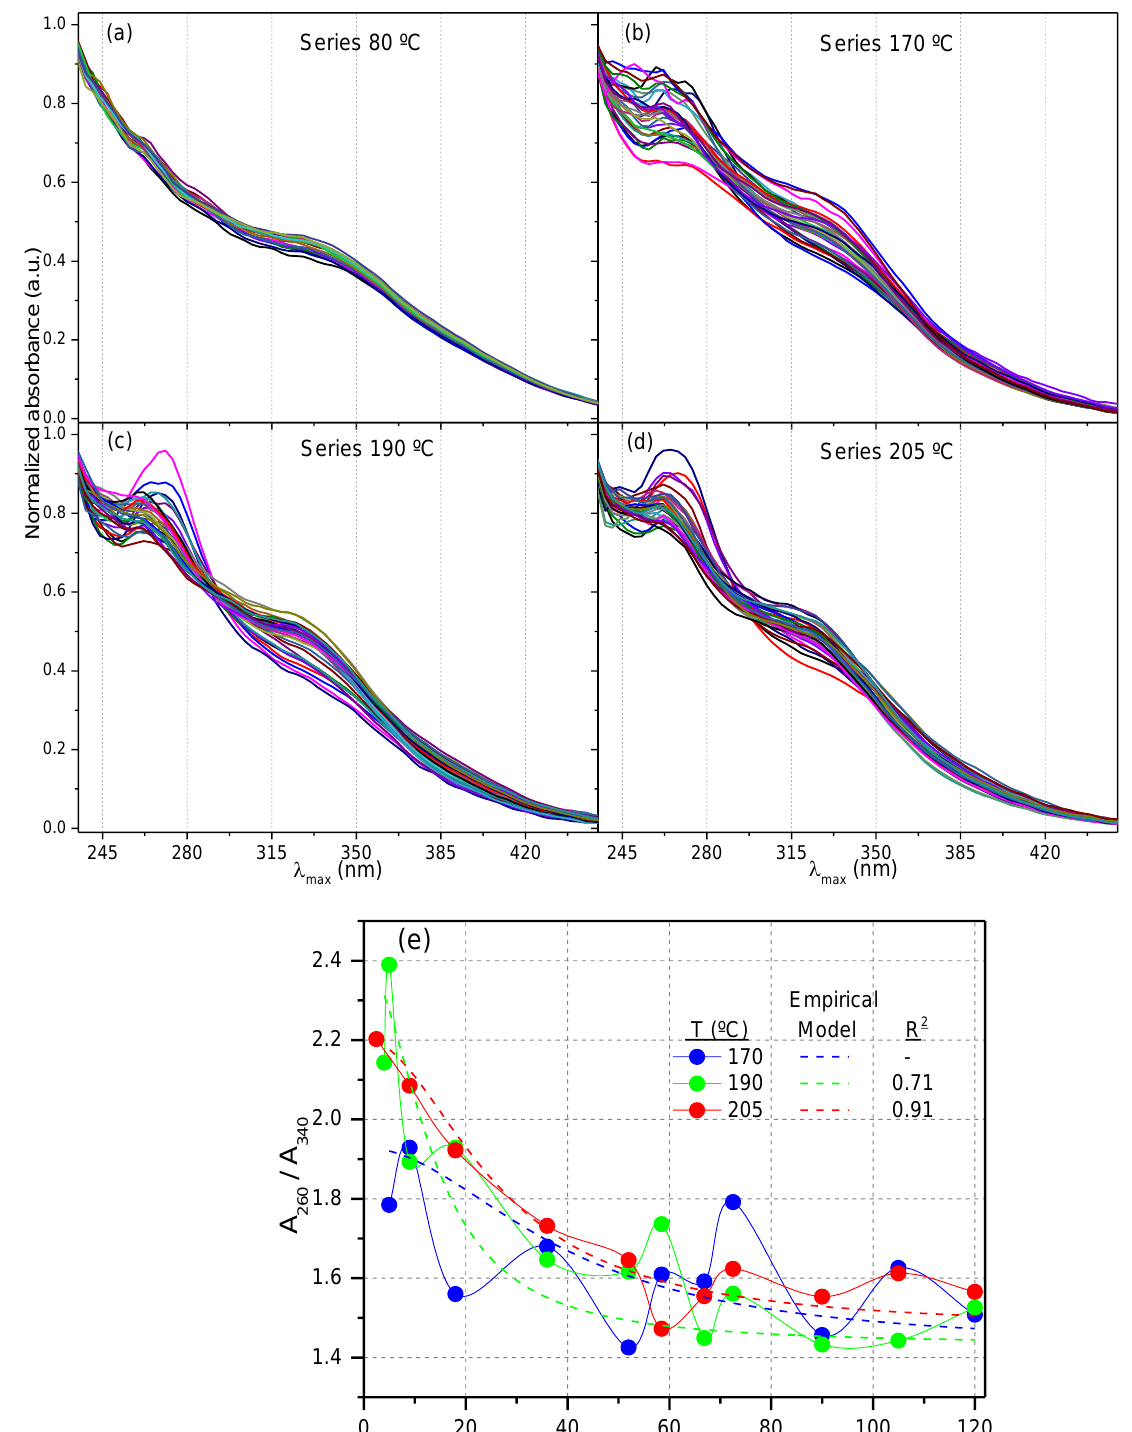
Figure 11. UV-Vis spectra of the raw soluble fractions (sol fractions) from the cyanide polymerizations: ( a ) using conventional heating at 80 °C, and ( b – d ) assisted by MWR at different temperatures, 170, 190 and 205 °C, respectively, from each of the triplicates of the samples synthesized using the conditions shown in Table S1; ( e ) evolution of the relationship between the intensity of the main bands observed in the UV-Vis spectra from the MWR series over time.